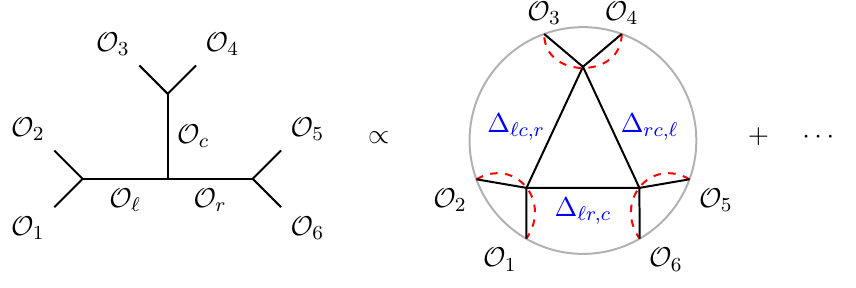
Figure 2. The global scalar six-point block W (cid:1) 1 ;:::; (cid:1) 6 discuss its holographic representation in this paper.